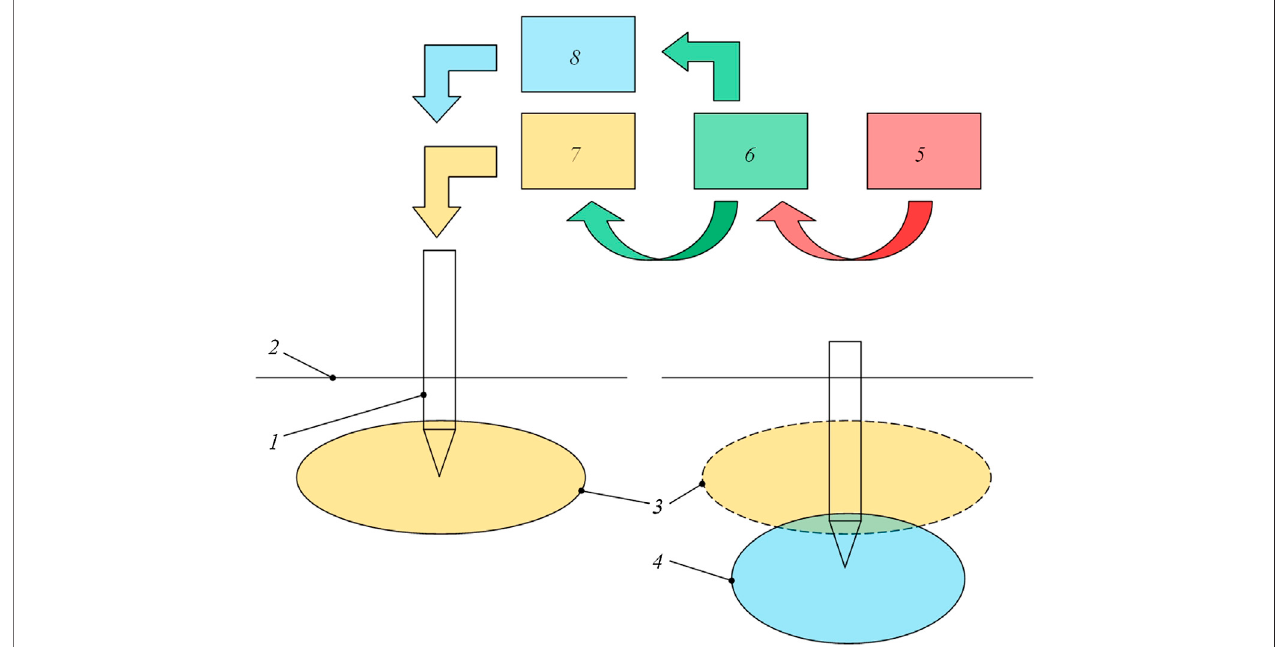
FIGURE 10 | Method of liquid biological drug based on CAP activated water pulsed intrasoil discrete injection and followed pulsed intrasoil discrete watering with CAP activated water.